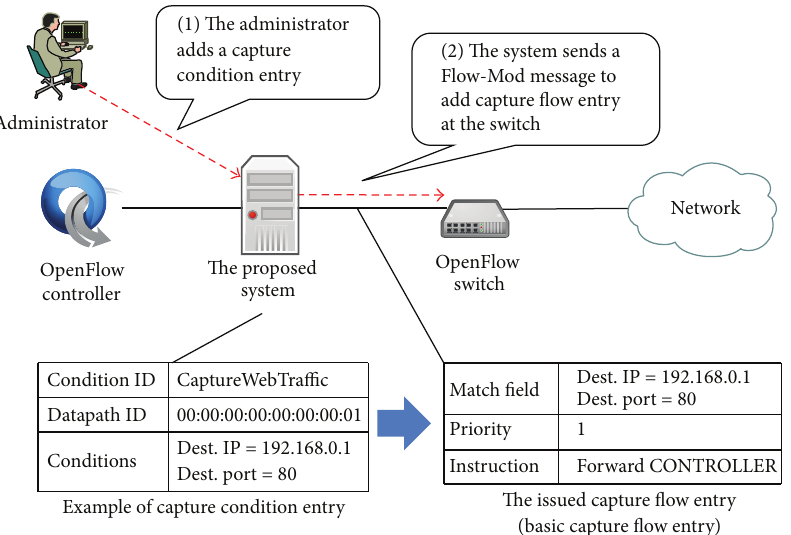
Figure 4: The basic behavior of capture module in the case of capture condition entry